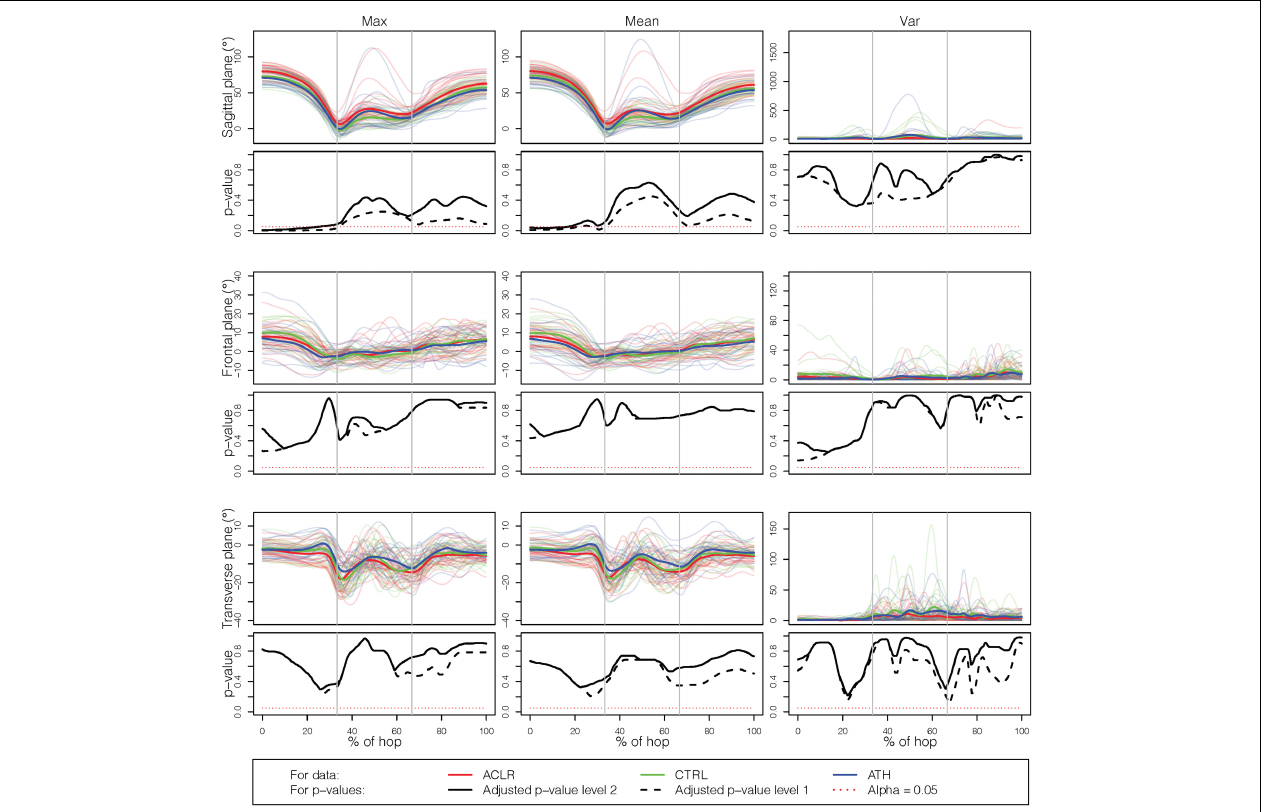
FIGURE 4 | Results for the single knee joint, comparing the injured leg with the non-dominant leg. The rows correspond to the three planes (sagittal, frontal, transverse) while the columns correspond to the different outcome measures (Max, Mean, and